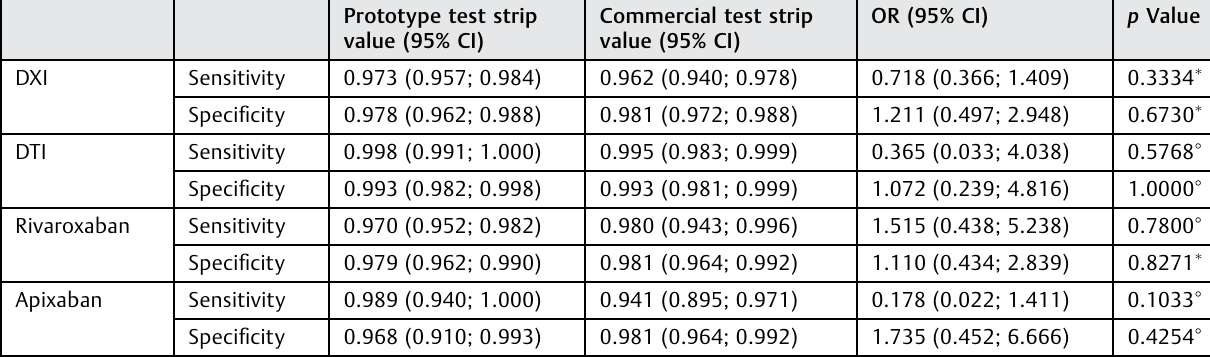
Table 6 Sensitivity, speci fi city and OR with 95%CIs for detection of DXIs, DTI, rivaroxaban and apixaban by prototype